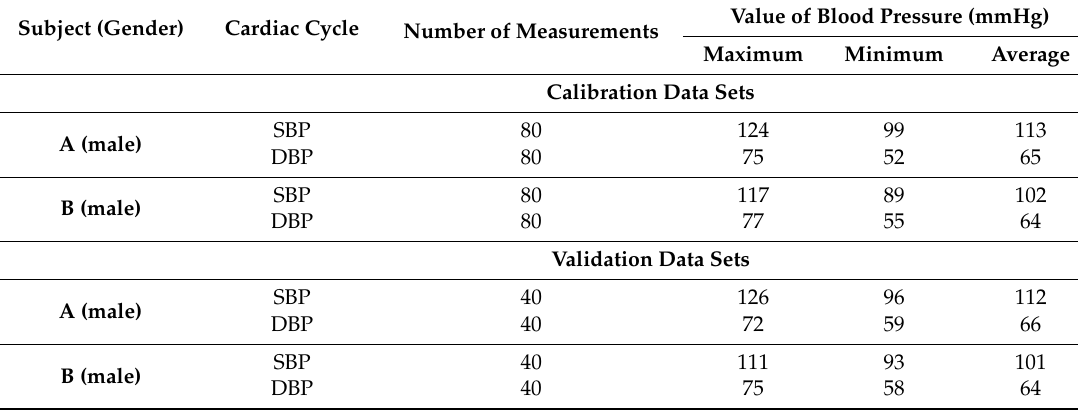
Figure 12. Result at DBP by PLSR for subject B: ( a ) calibration and ( b ) validation. Table 2. Details of reference blood pressure at calibration and validation.